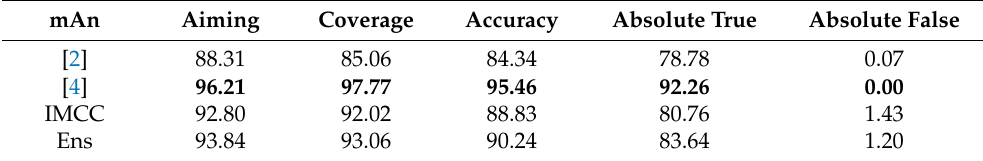
Table 7. Performance comparison of Ens and IMCC on the mAn data set. Bold highlights supe- rior